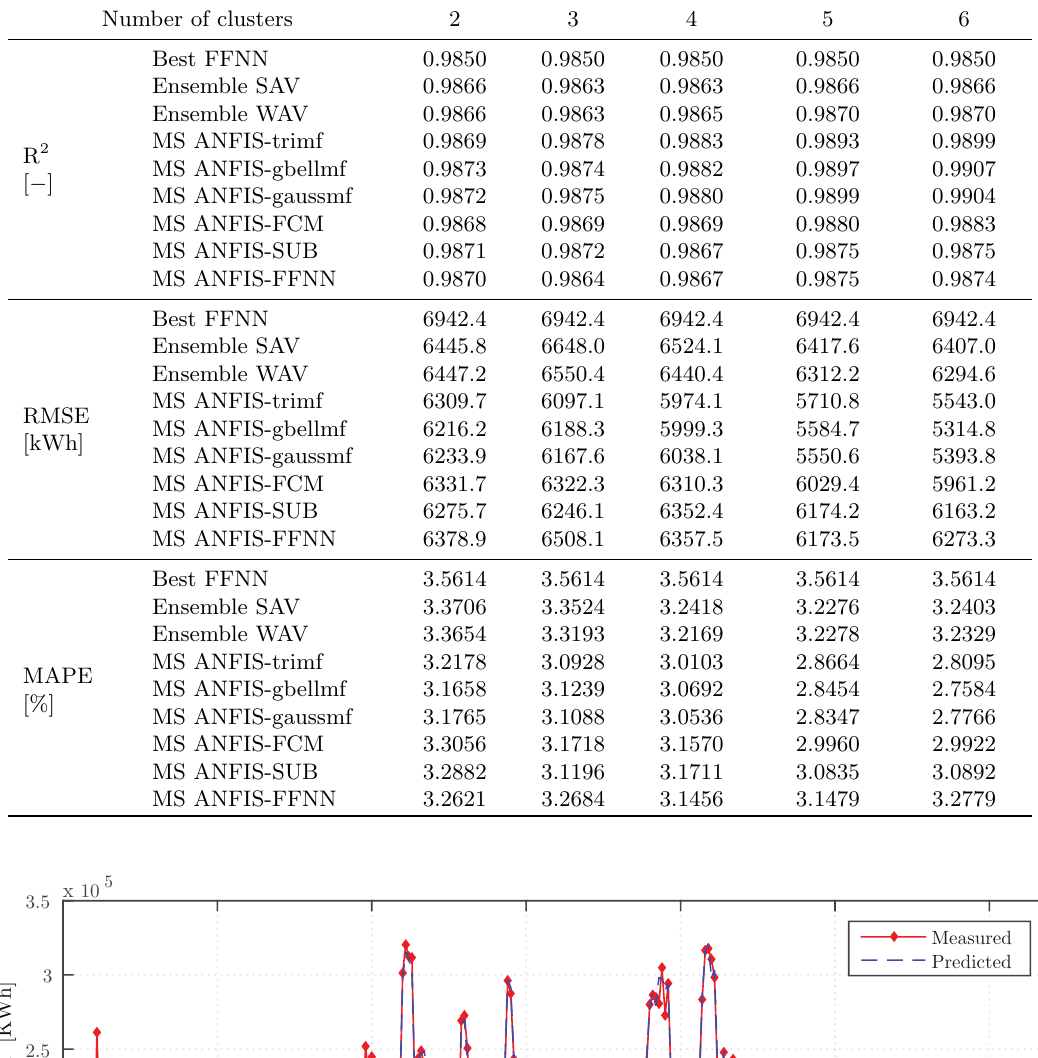
Table 1: Prediction indices for training networks